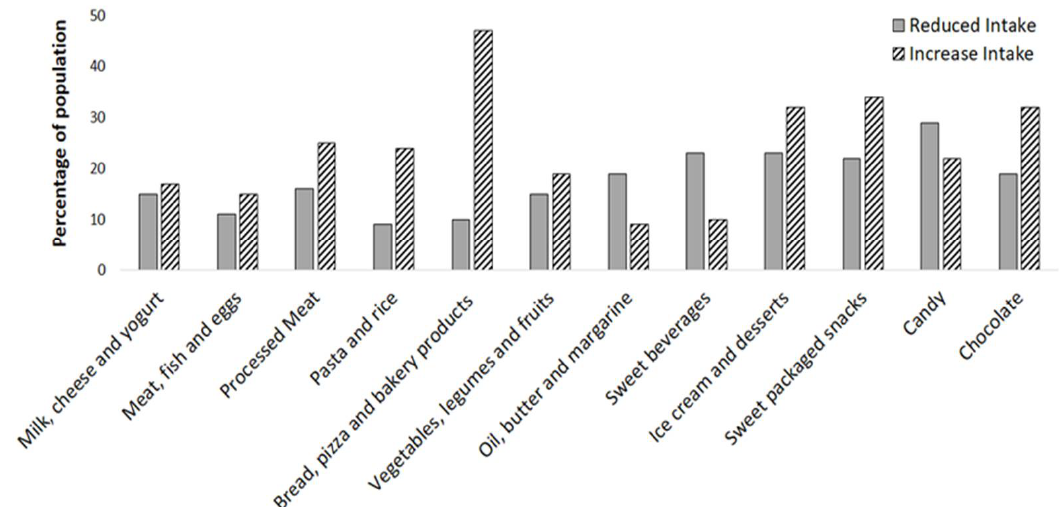
Figure 2. Proportion of the population who changed their eating habits during the first COVID-19 lockdown.